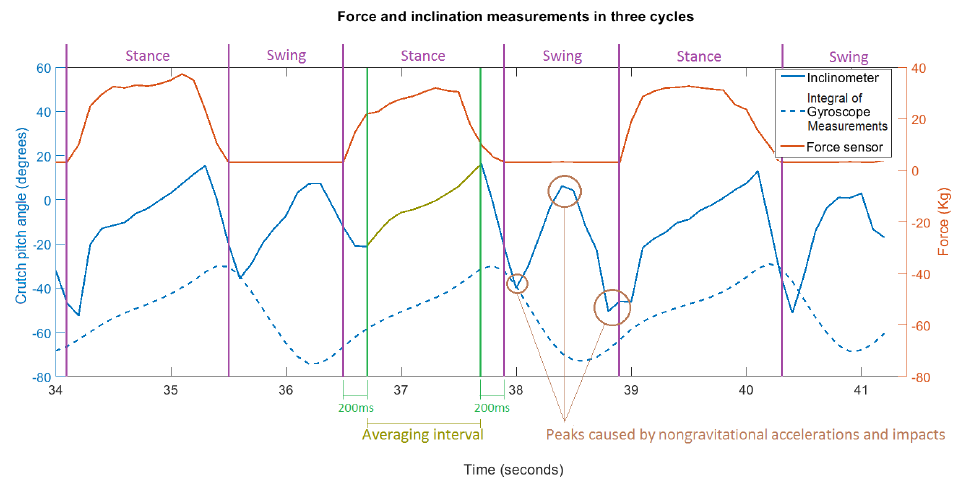
Figure 7. Force and inclination measurements during three cycles.